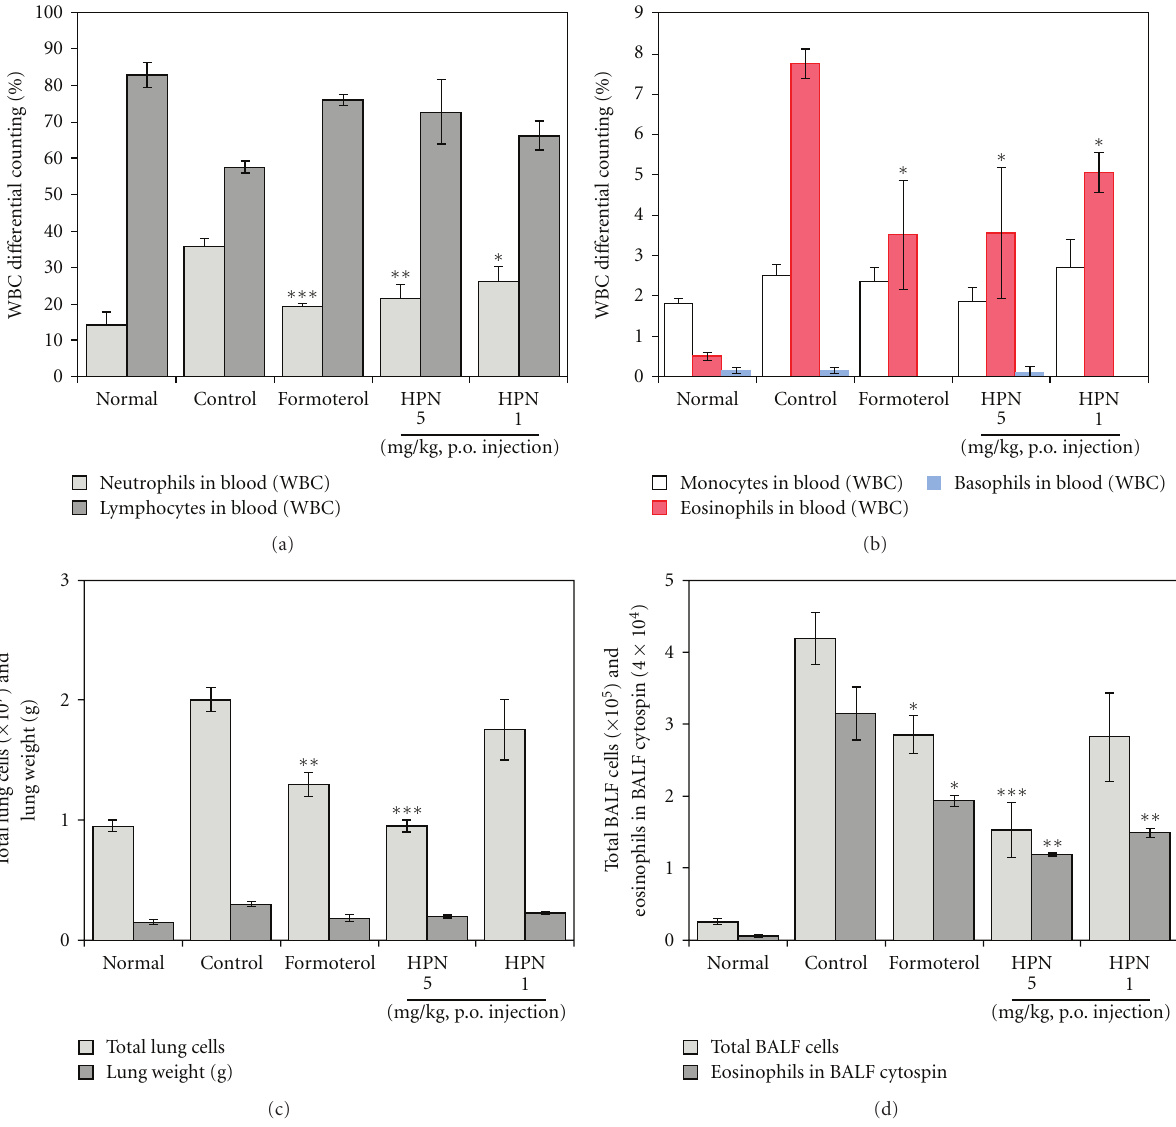
Figure 2: E ff ects of HPN on total eosinophils, neutrophils, and basophils in blood and total lung cells, total leucocytes, and eosinophils in BALF. As described in Section 2, whole blood was harvested 24hrs after the last OVA challenge. Total inflammatory cell numbers in blood were counted, and cell classification was performed on a minimum of 200 cells to classify eosinophils and lymphocytes. Results are expressed as mean ± S.E ( N = 5). Statistical significance between control and treatment groups was assessed by ANOVA ( ∗ P < . 05, ∗∗ P < . 01, ∗∗∗ P < . 001). N : normal BALB/c mice, CT: Ovalbumin inhalation+vehicle, formoterol: OVA + formoterol (1mg/kg), OVA + HPN (5,